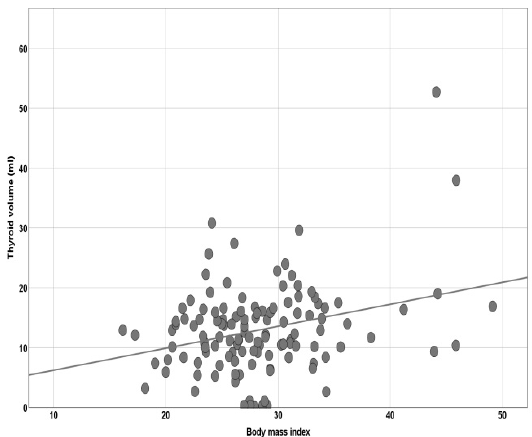
Figure 3. Pearson’s correlation of thyroid volume and BMI.